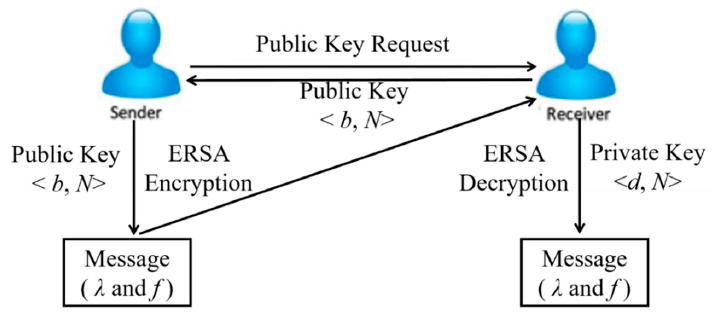
Figure 2. A schematic diagram of ERSA.